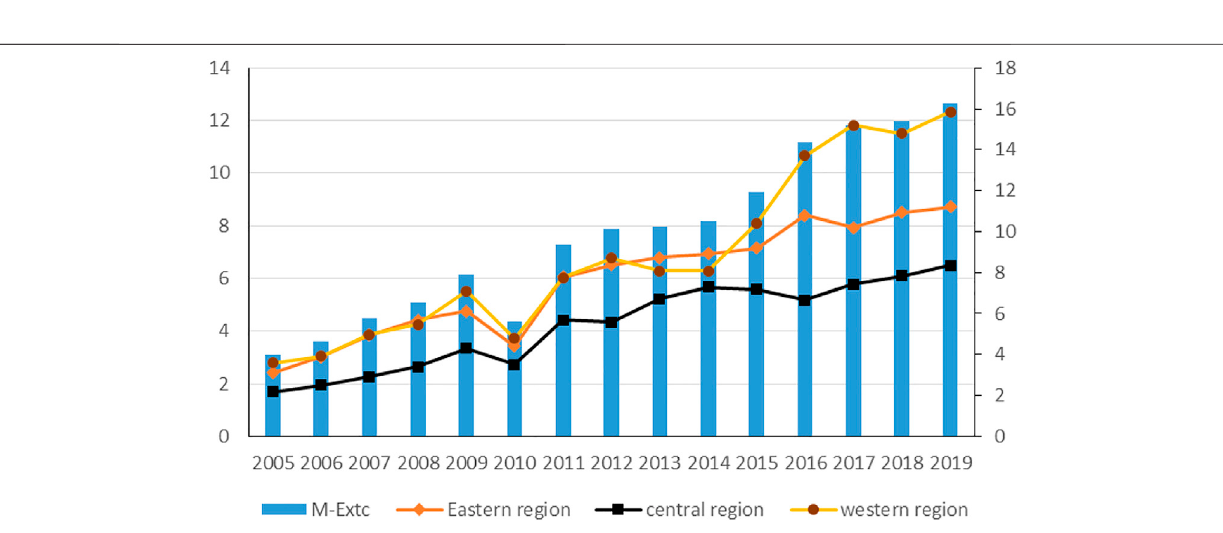
FIGURE 2 | Regional distribution of the technical complexity of export agricultural products (2005 – 2019) (unit: each). Data source: China ’ s customs database. Note: 1) M-Extc represents the annual average export technical complexity index. 2) M-Extc is displayed on the right axis, and the technical complexity of different areas are displayed on the left half